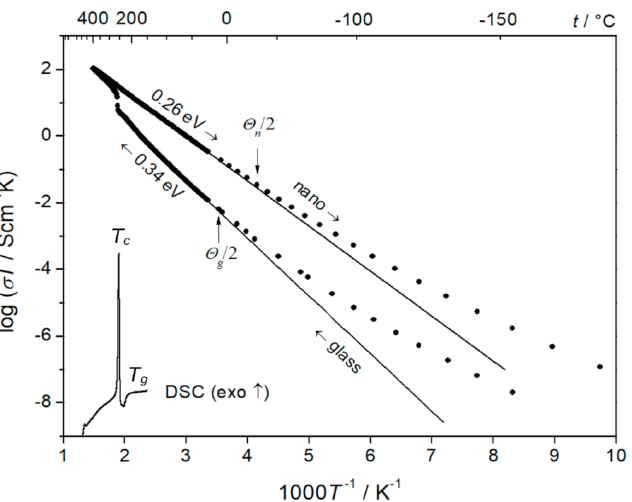
Figure 5. Temperature dependences of conductivity of 90V 2 O 5 · 10P 2 O 5 glass and nanomaterial in an extended temperature range from − 170 ◦ C up to +400 ◦ C. A DSC run taken on heating is shown for comparison. (Reproduced with permission from ref. [35]. Copyright 2011,